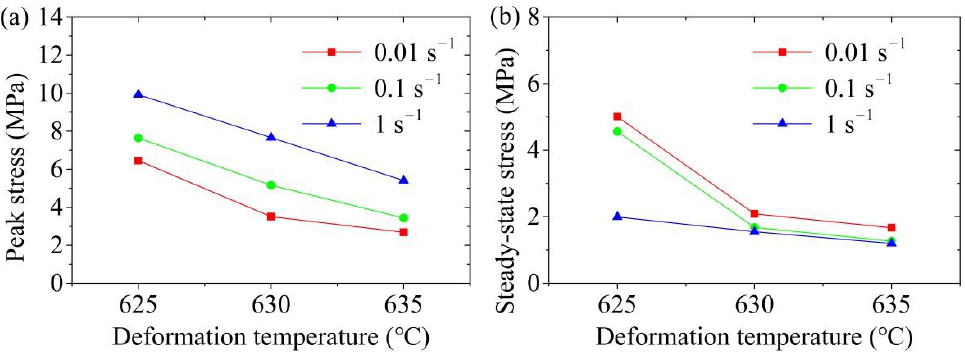
Figure 5. Influence of the deformation temperature in SSIC on the ( a ) peak stress, and ( b ) steady-state stress.